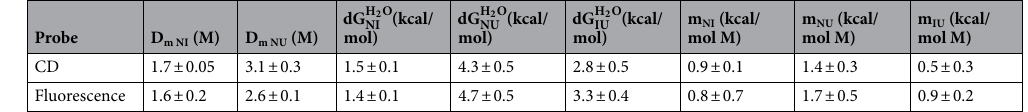
Table 3. GdnHCl-mediated equilibrium unfolding parameters of AAR. The values are mean of three measurements along with the standard error of the mean.